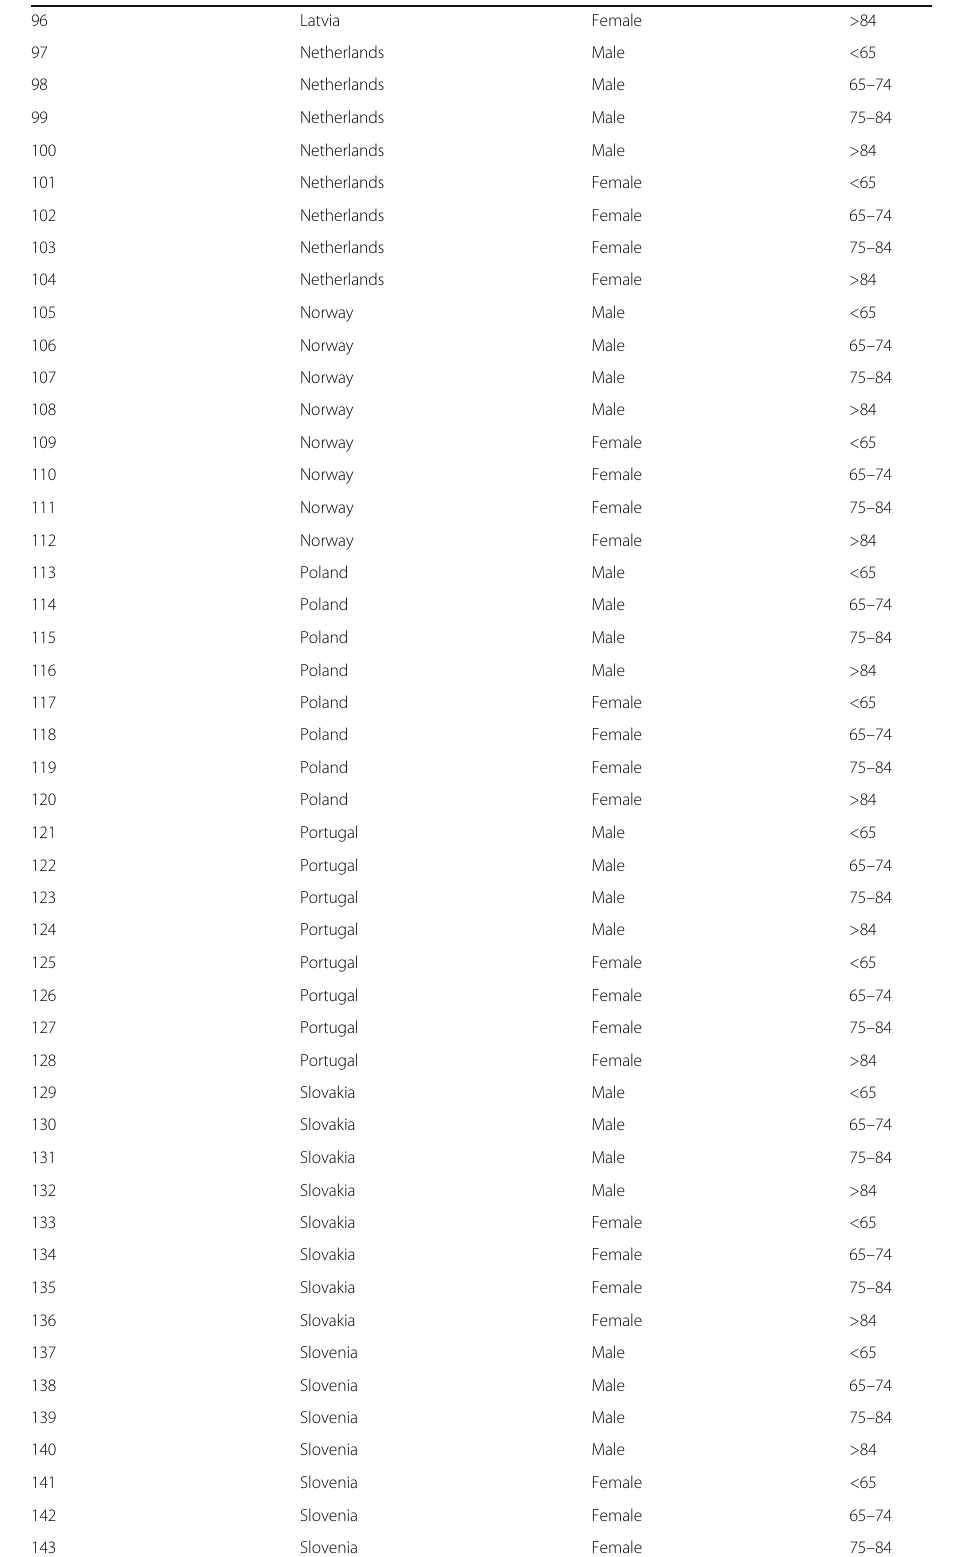
Table 3 Order of time series used in the analysis